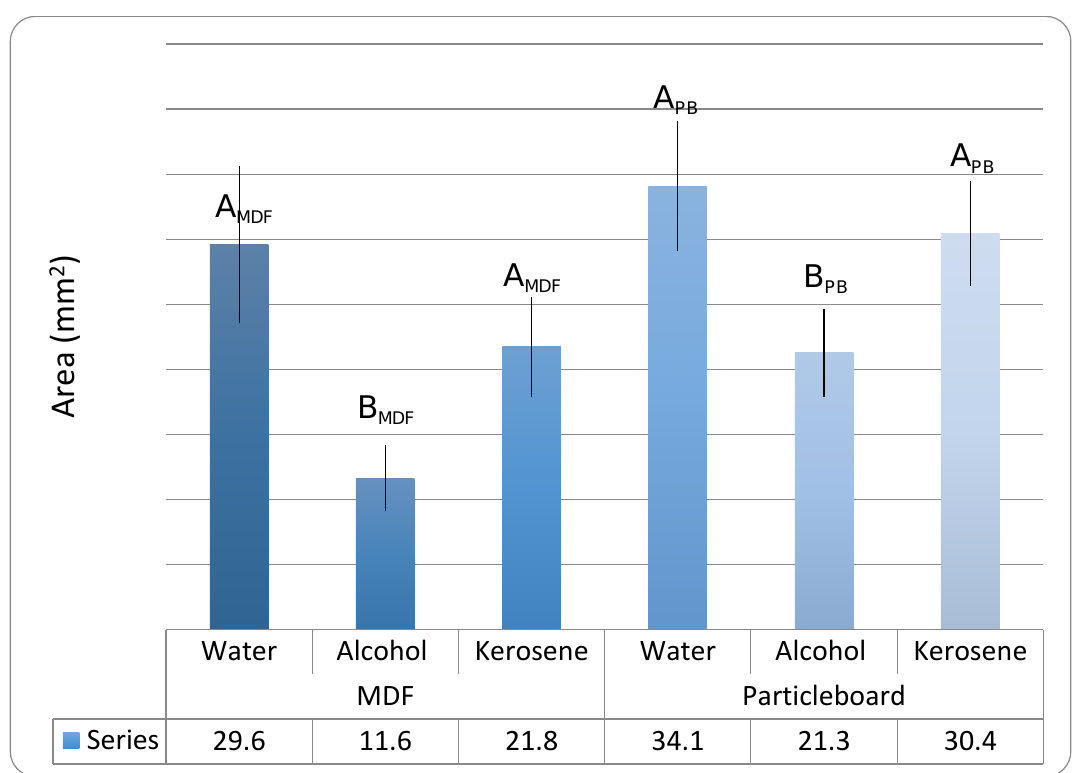
Figure 4. The wetted area in the wood-based composite specimens measured once the drop of liquid penetrated into the surface of composite specimen and fully disappeared (letters on each column represent Duncan’s multiple range test, α = 0.05, separately carried out for either MDF or particleboard). MDF = medium-density fiberboard; PB = particleboard.